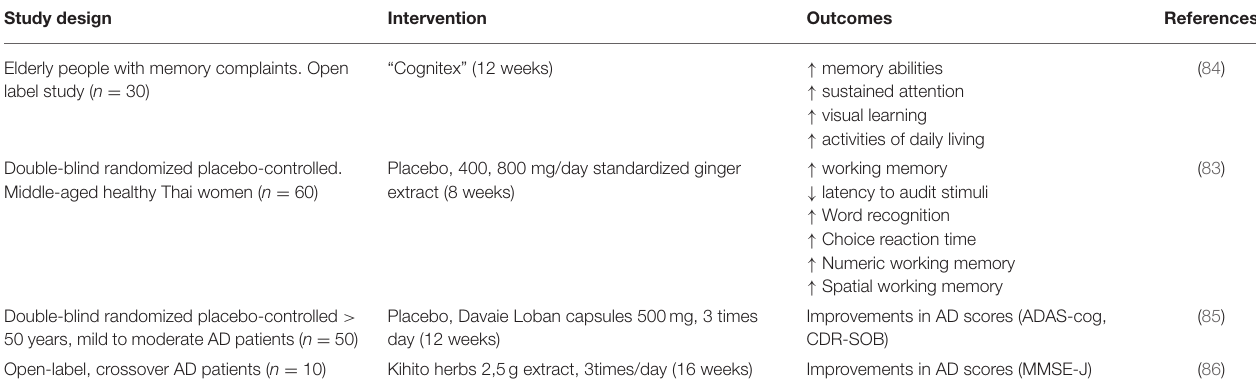
TABLE 2 | Human clinical studies on ginger and cognitive function. Study